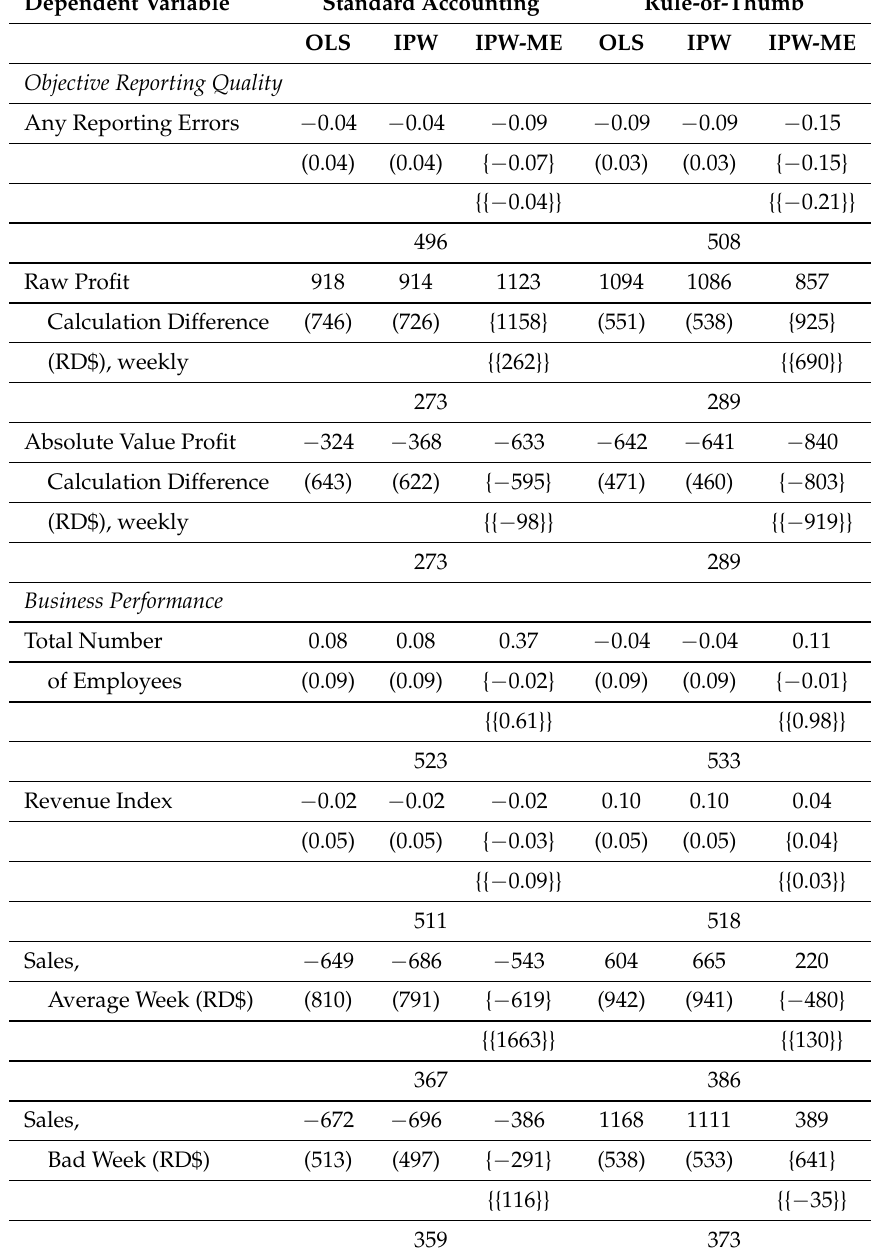
Table 5. Impact of Training on Business Practices and